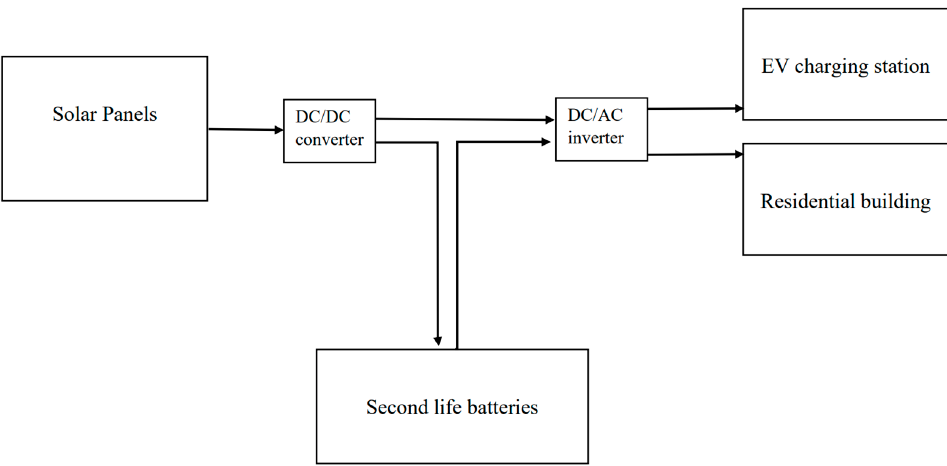
Figure 1. Schematic block diagram of the proposed off-grid energy system.